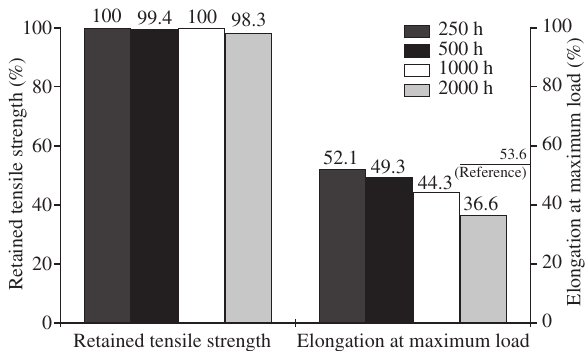
Figure 8 Retained tensile strength and elongation at maximum load of the GTX B2 after the weathering